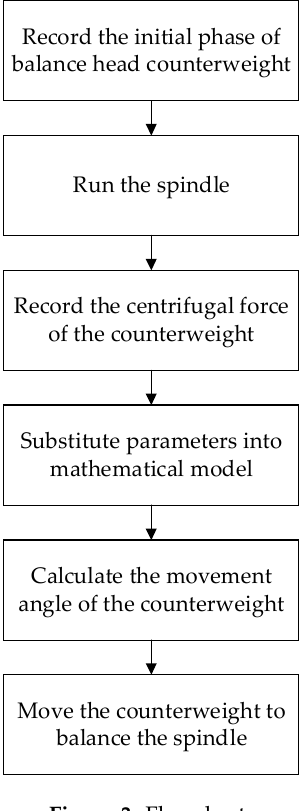
Figure 3. Flowchart. Figure 3.